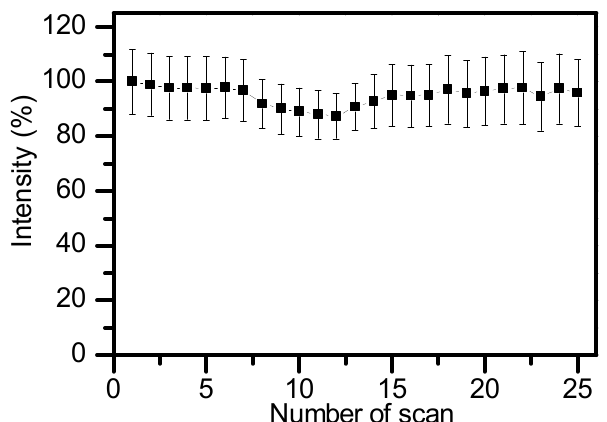
Figure 7. Photostability of AIE–Fe nanodots (10 ppm).